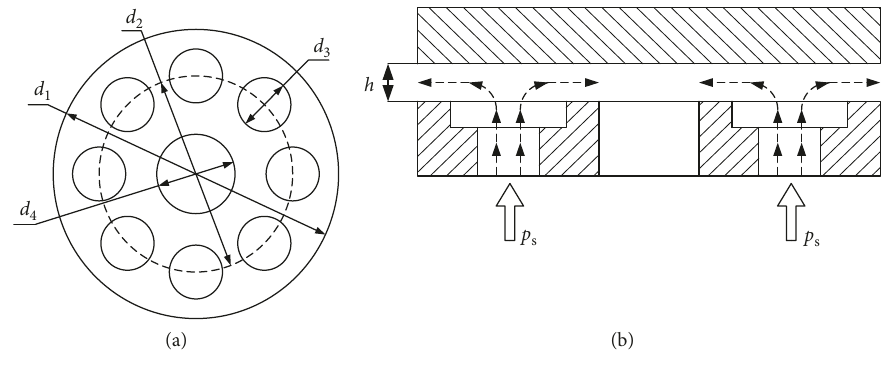
Figure 1: Structure of